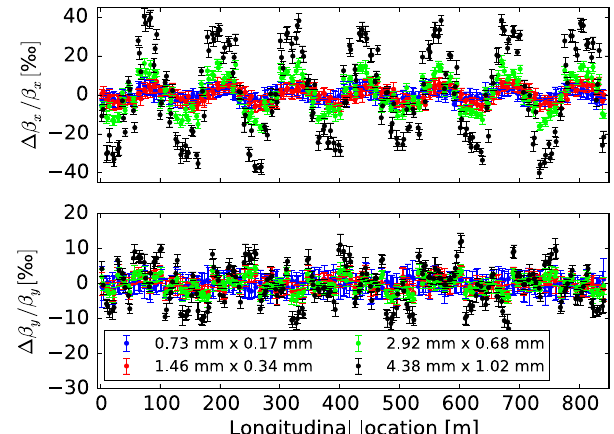
FIG. 4. Simulated artificial β -beating computed by N-BPM from single-particle simulations of the ESRF storage ring lattice at different initial displacements ( β x ¼ 38 m and β y ¼ 2 . 9 m) corresponding to actions from ∼ 5 × 10 − 9 m to ∼ 2 . 5 × 10 − 7